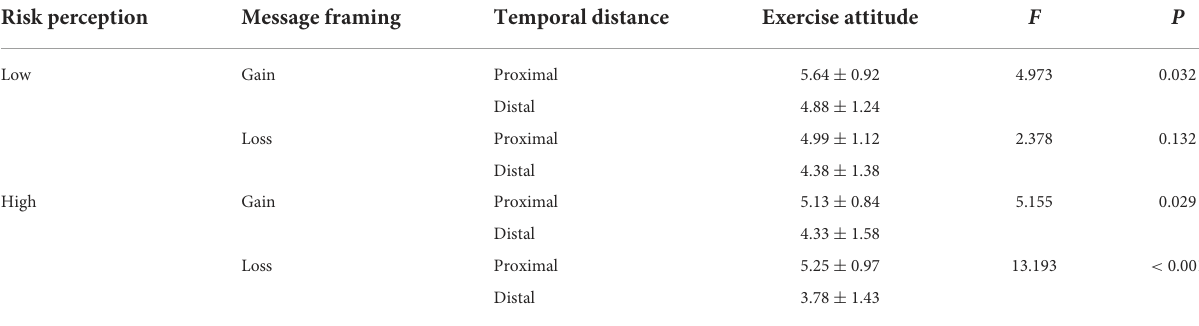
TABLE 2 Results of simple main